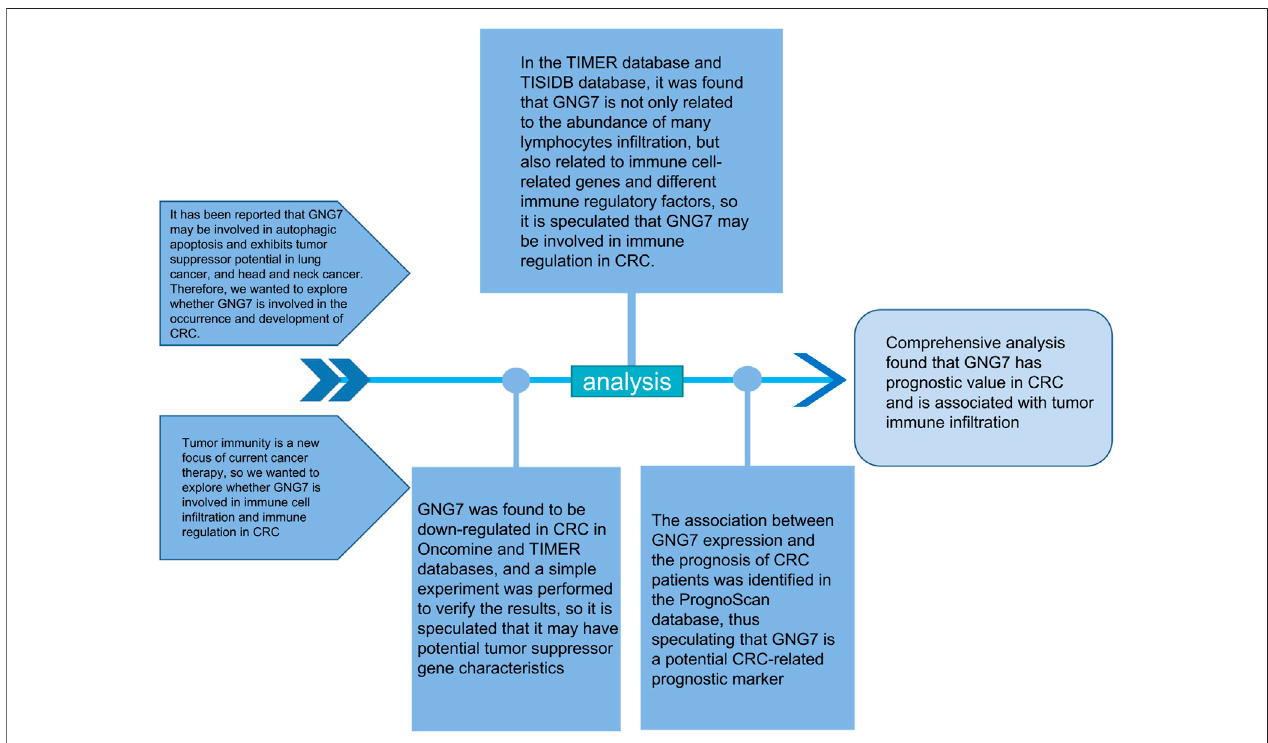
FIGURE 1 | Illustration of the main principle of this